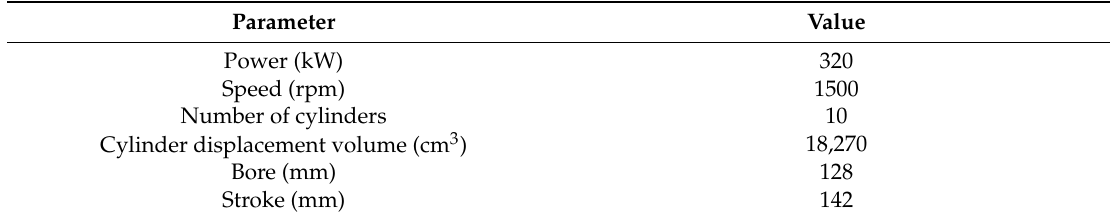
Figure 1. Engine analyzed in the present work. Table 1. Technical specifications at 100% load.